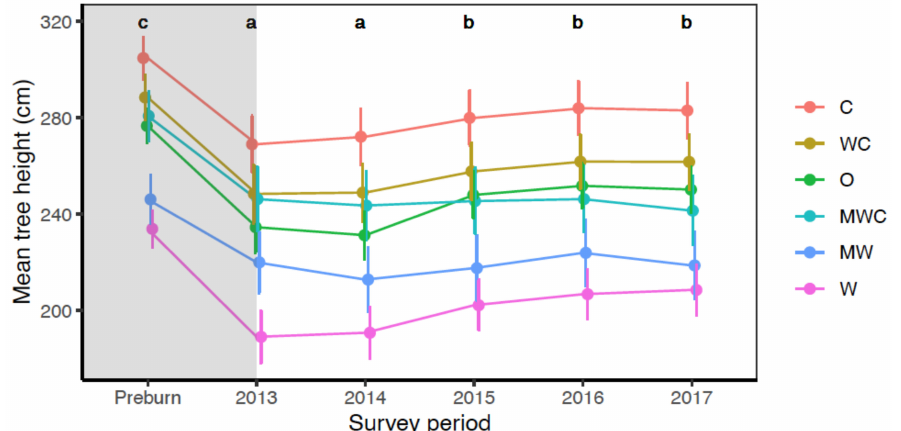
Figure 4. Yearly changes in mean tree height across the six herbivore treatments. Letters inside the graph denote significant yearly differences in mean heights. Sampling periods where the average tree height differs significantly from the subsequent years are annotated with different